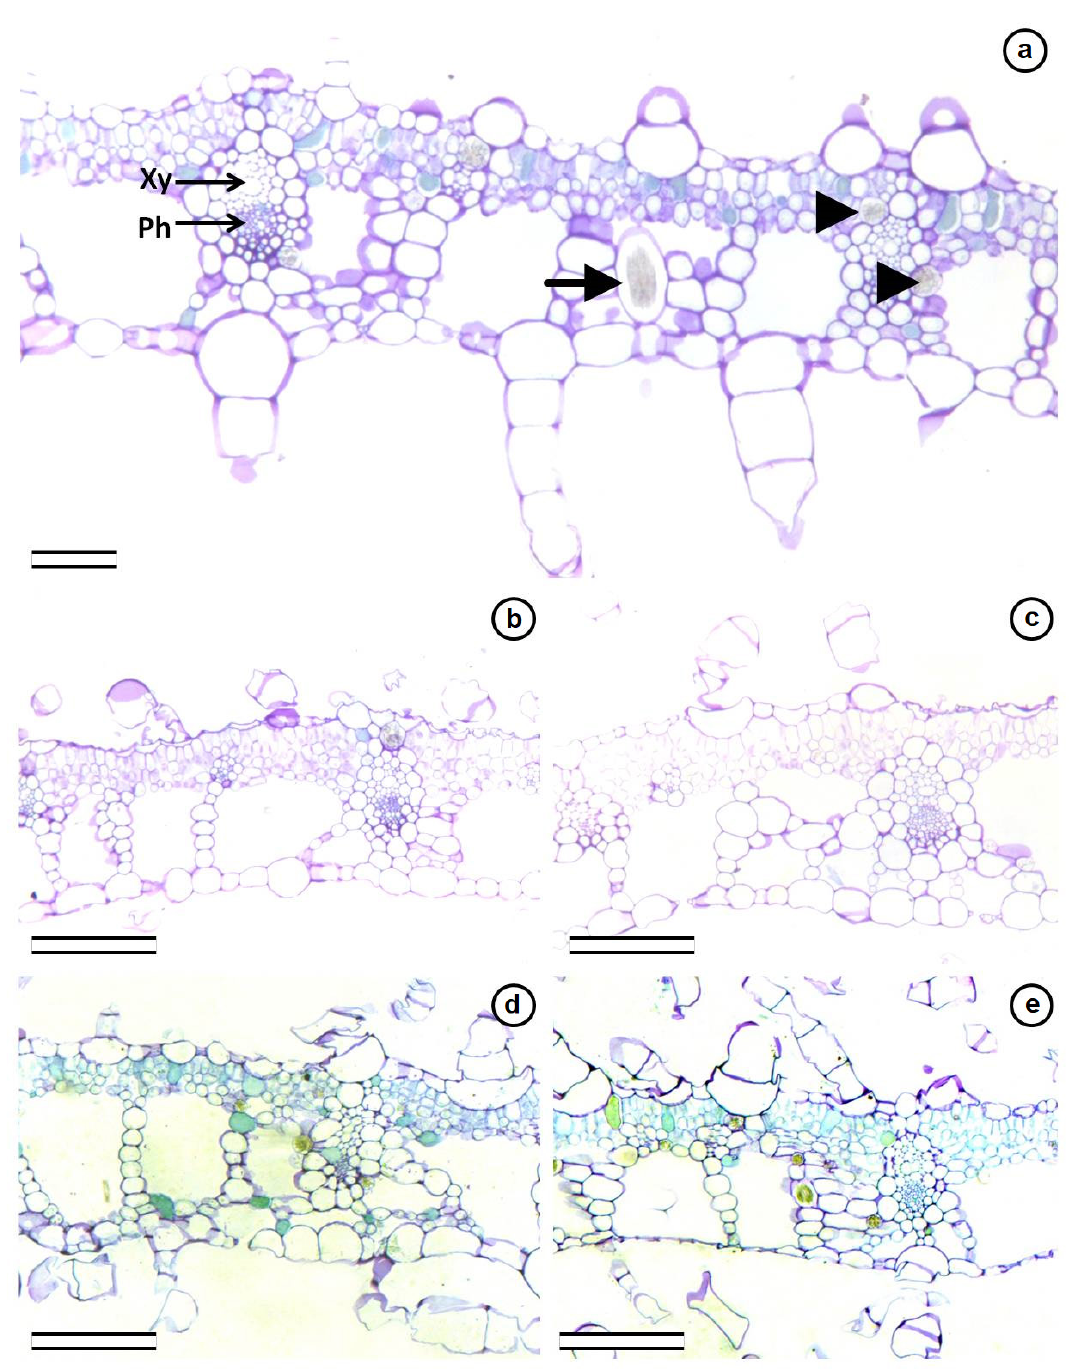
Figure 5. Cross sections of leaf blade of P. stratiotes subjected to clomazone application. a . Control; b and c . Plants subjected to 0.111 and 1.0 mg L -1 at 7 days after clomazone application. Note that the thickness of leaf blade does not change significantly regardless of the concentration of clomazone applied. d and e . Plants subjected to 0.037 and 1.0 mg L -1 at 15 days after clomazone application. Note that the abaxial epiderm is in e is much thinner than in d while the palisade parenchyma in e is thicker than in d . arrowhead = druse; arrow = raphide; Ph v phoem; Xy =